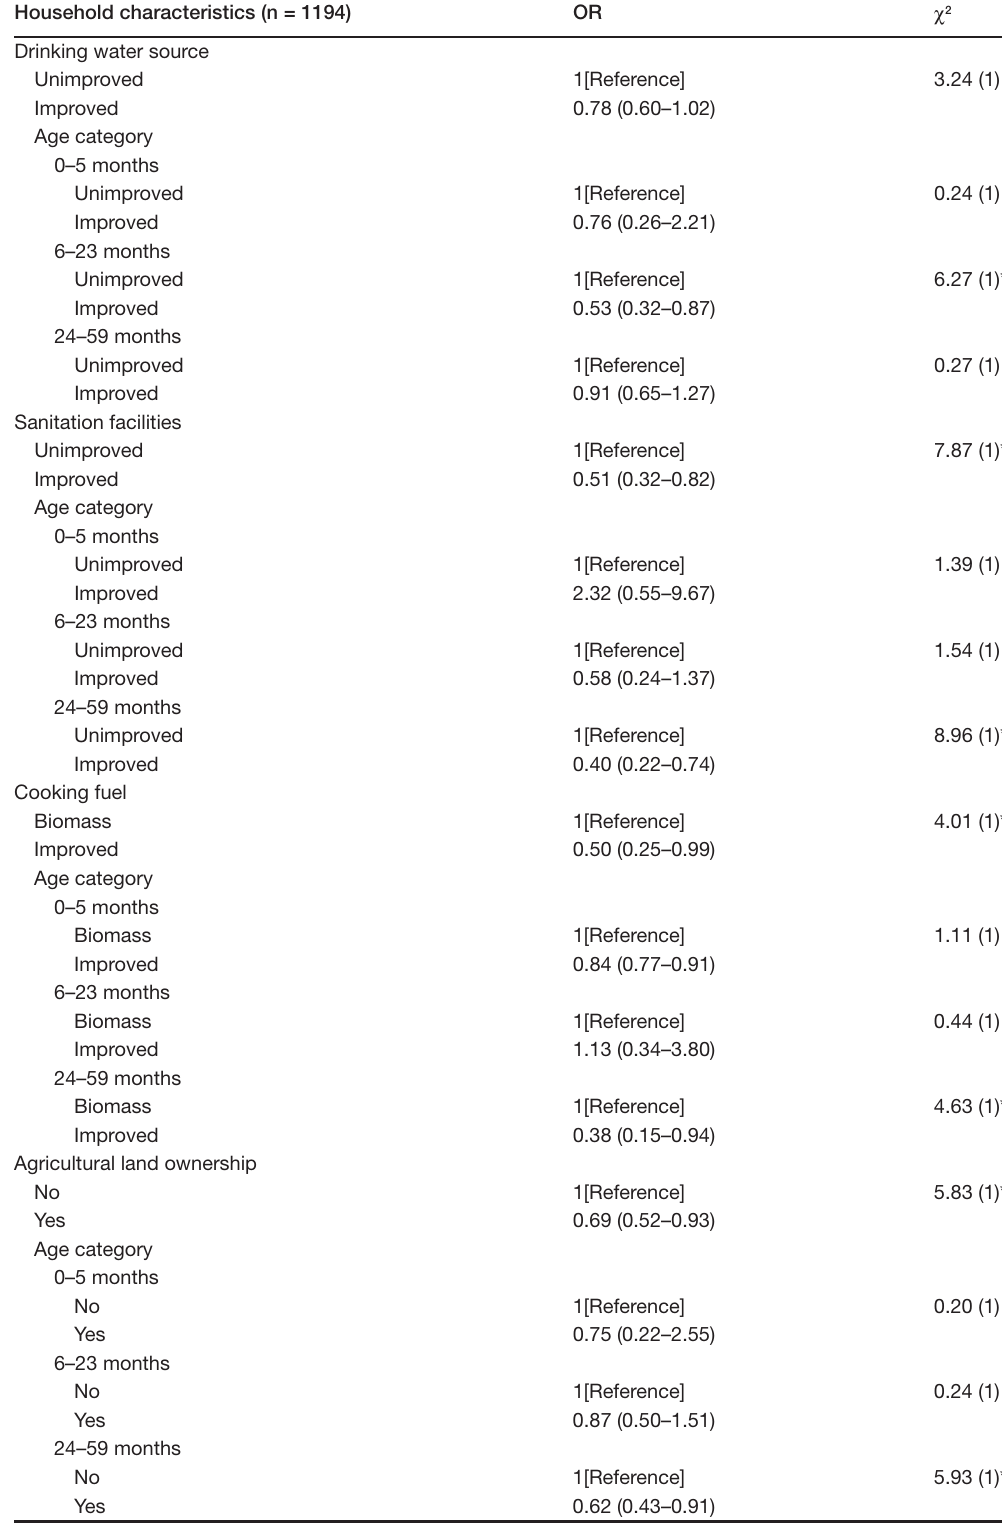
Table 2. OR and χ 2 for household characteristics on stunting (HAZ <−2) standardised coefficients and CIs. Household characteristics (n = 1194) OR χ 2 Drinking water